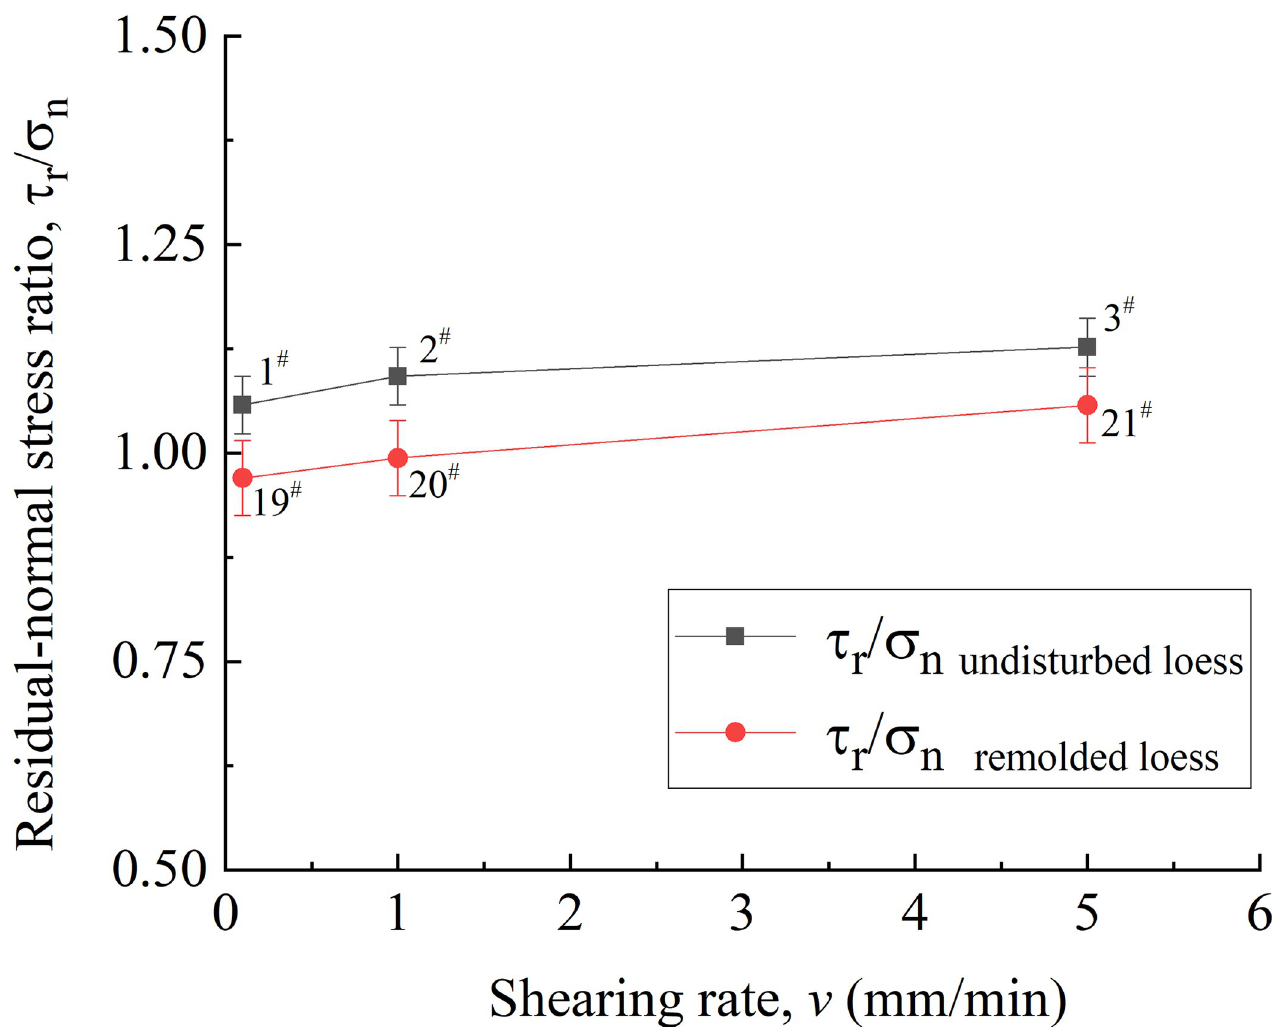
Fig 21. Residual friction coefficient-shear rate curve of 1 # - 3 # undisturbed and 19 # - 21 # remolded loess specimens.